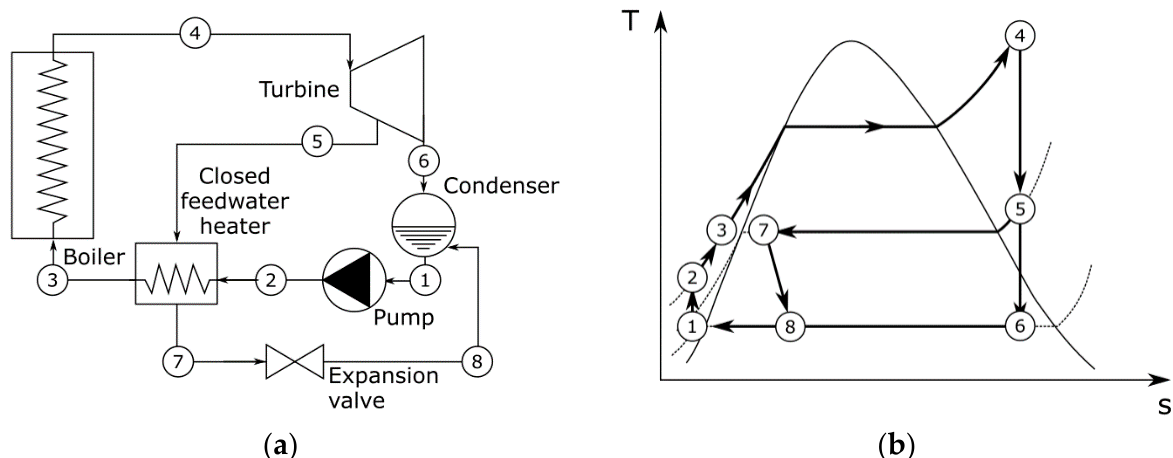
Figure 16. ( a ) Equipment and ( b ) T-s diagram of an ideal regenerative Rankine cycle with a closed feedwater heater.